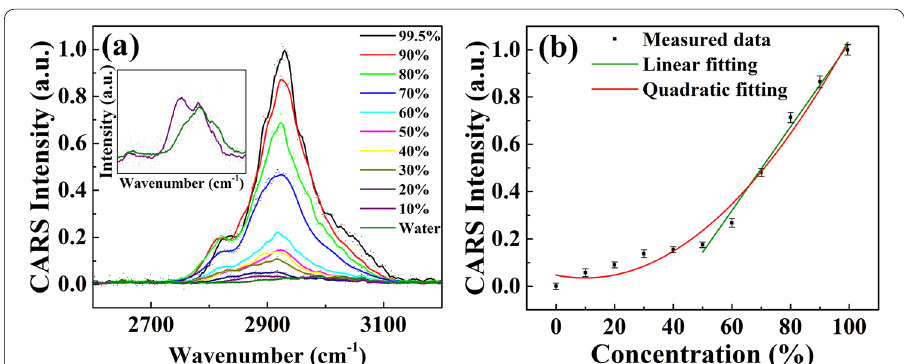
Fig.10 a CARS spectra of acetone with different volume fractions in water. Inset: CARS spectra of 10 v/v% acetone and water. b Relative CARS intensity at 2921 cm − 1 for increasing volume fractions of acetone in